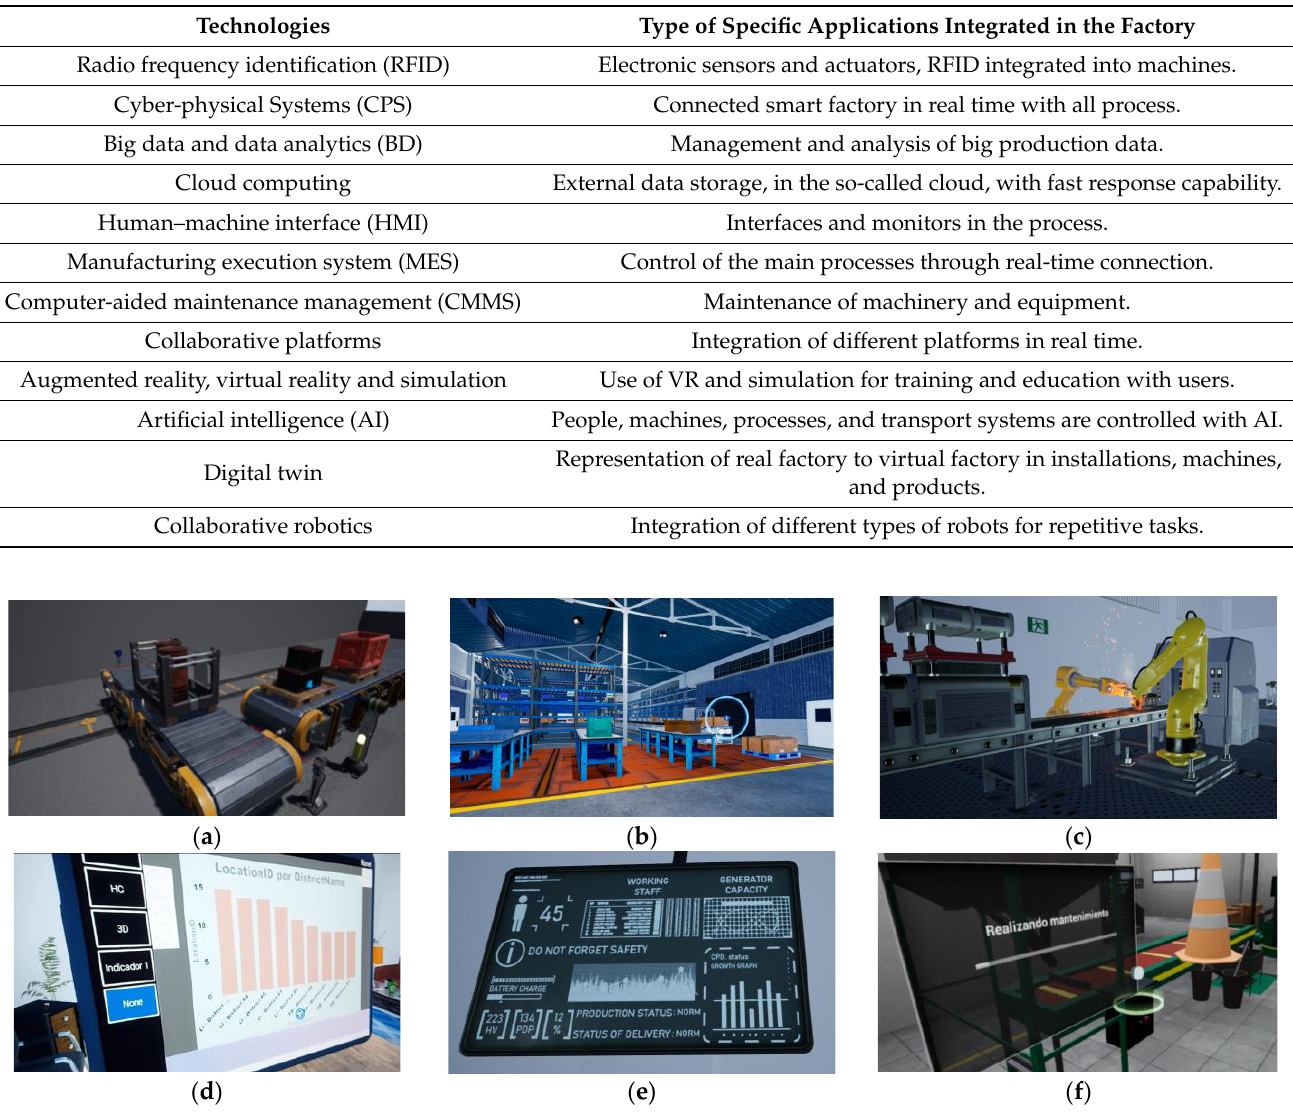
Table 3. Applications of Industry 4.0 technologies in the case study project.